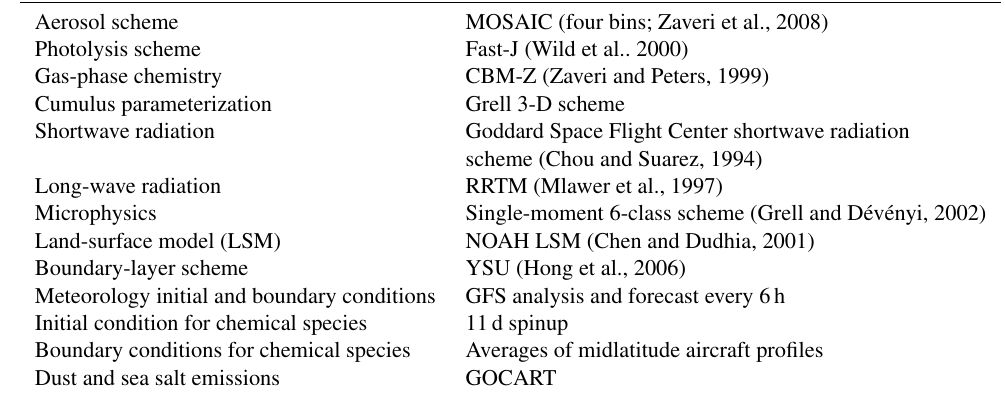
Table 1. WRF-Chem model